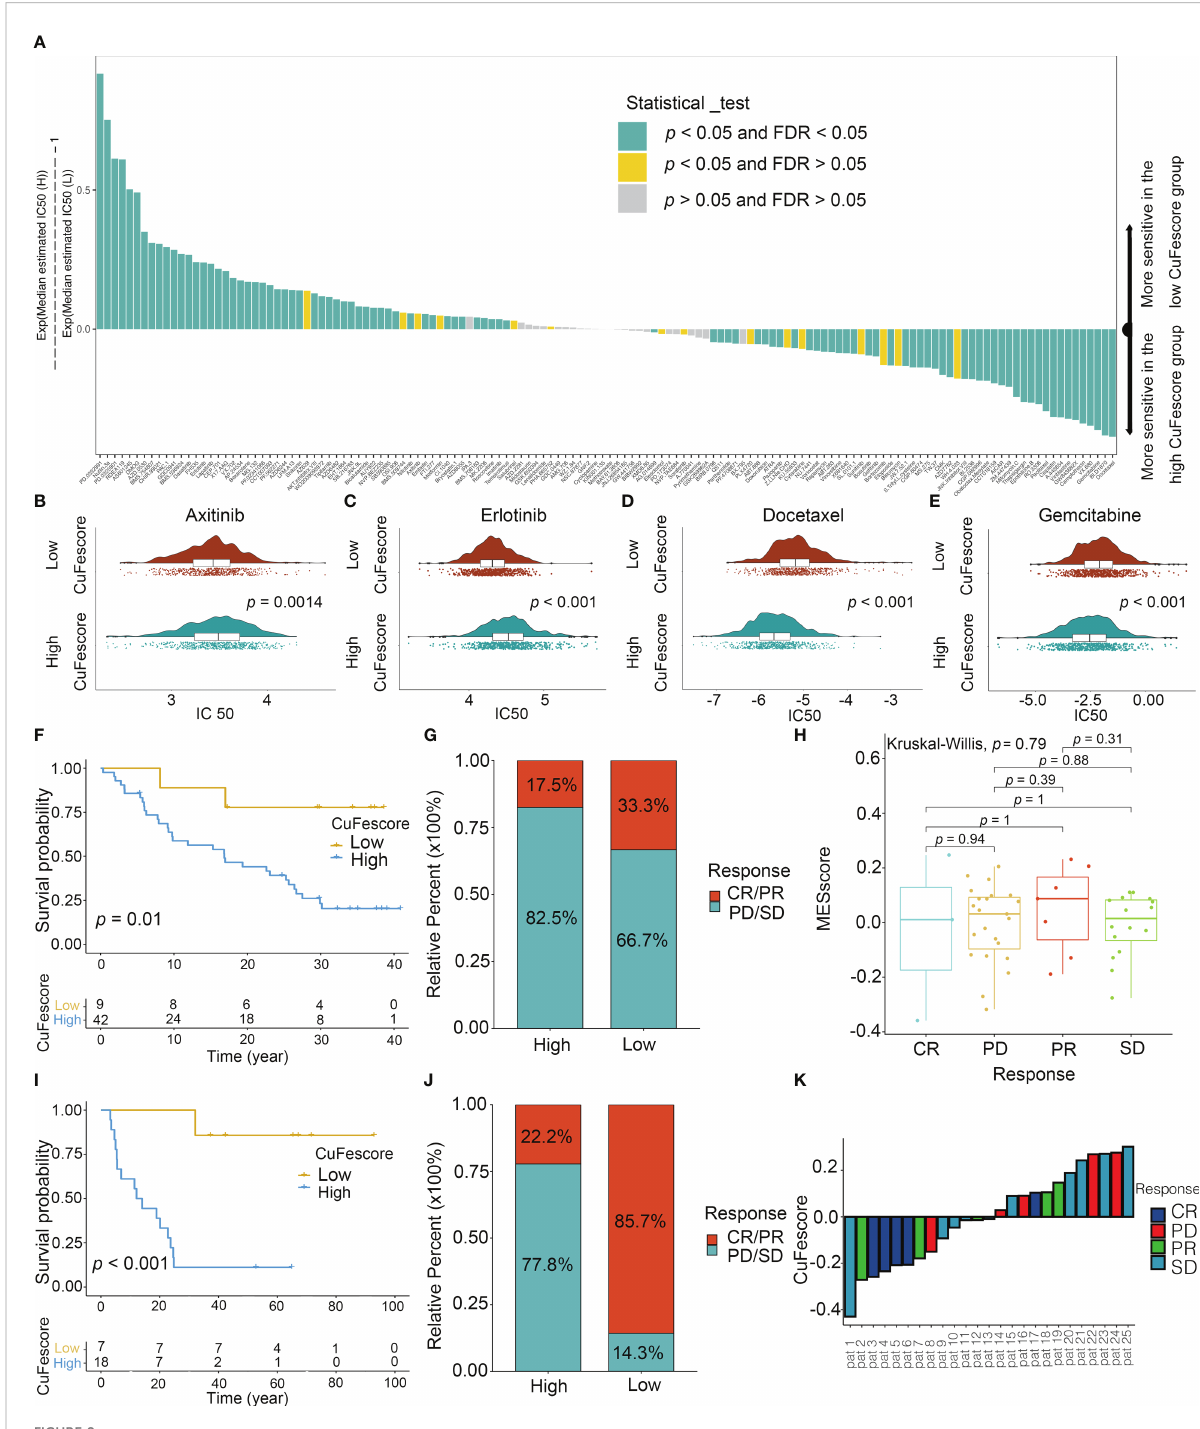
FIGURE 8 Role of the CuFescore in the chemotherapy and immunotherapy. (A) Sensitivity of 138 drugs. Ef fi cacy of (B) axitinib; (C) erlotinib; (D) docetaxel and (E) gemcitabine. (F) Kaplan-Meier curves of survival in the patients receiving anti-PD-L1 therapy in GSE91061. (G) Proportion of patients with response to PD-1 blockade immunotherapy in the high and low CuFescore groups. (H) Distribution of CuFescore in distinct anti-PD1 clinical response groups. (I) Kaplan-Meier curves of survival i8n the patients receiving adoptive T cell therapy in GSE10797. (J) Proportion of patients with response to adoptive T cell therapy in the high and low CuFescore groups. (K) Correlation of CuFescore with clinical response to adoptive T cell therapy. IC 50, half maximal inhibitory concentration; FDR, false discovery rate; MEscore, module eigengene score; CR, complete response; PD, progressive disease; PR, partial response; SD, stable